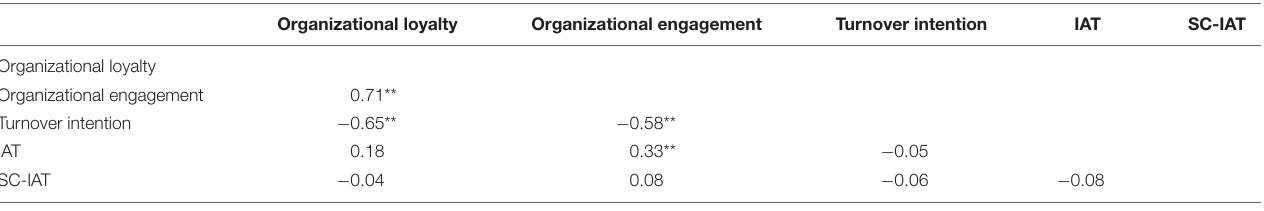
TABLE 5-1 | Correlation of staff.